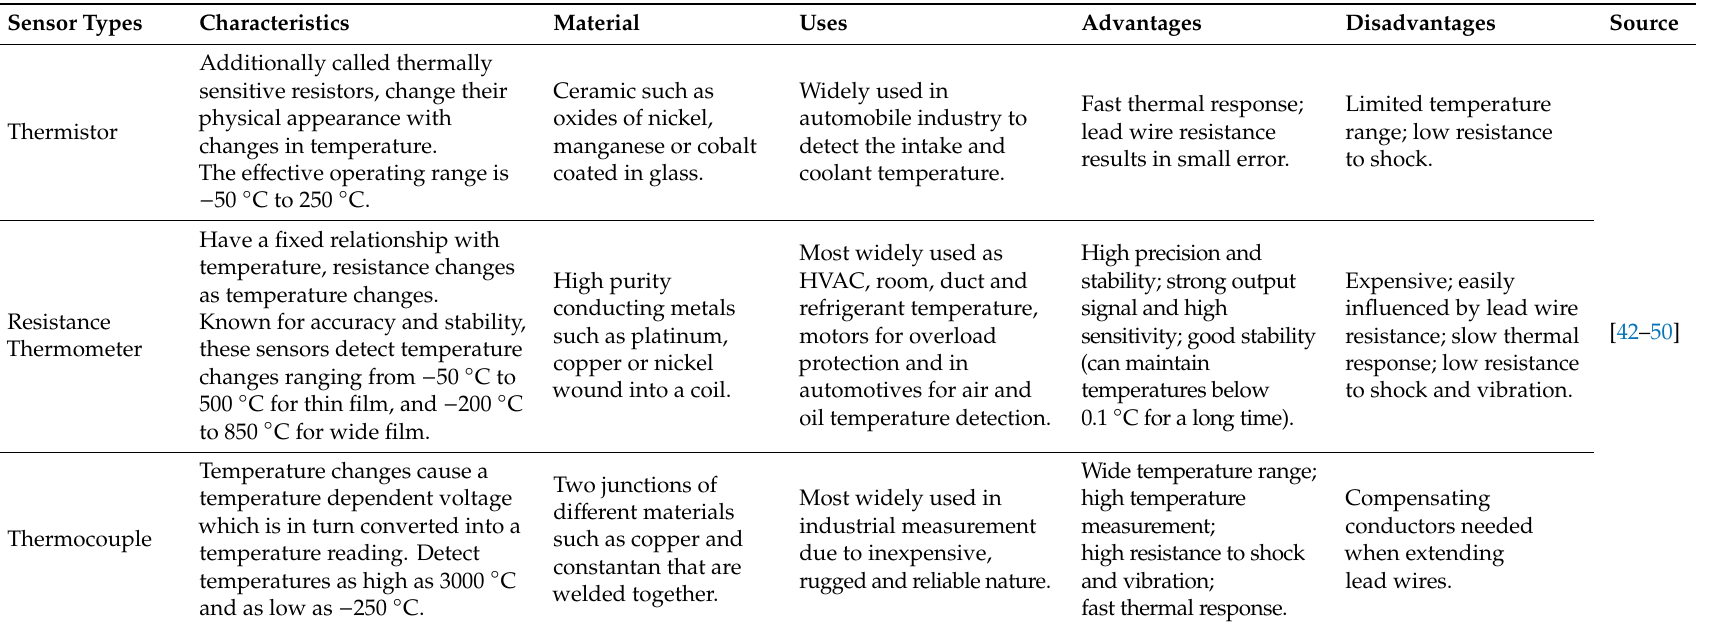
Table 2. Key features of temperature